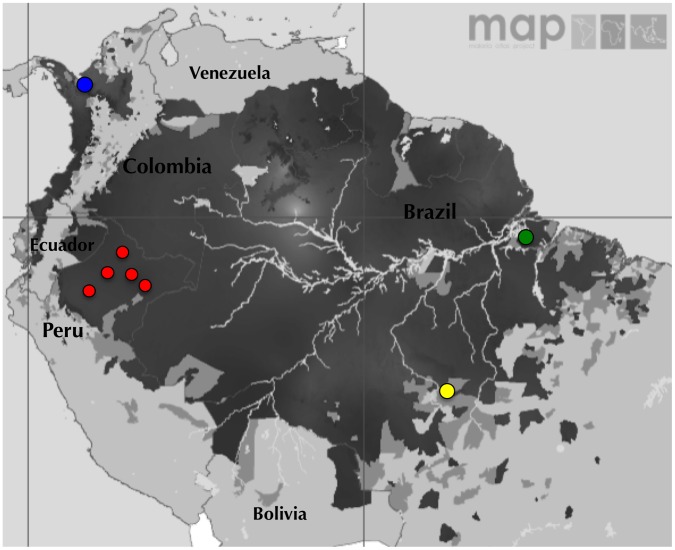

Plasmodium falciparum malaria endemicity in South America and geographic location of the sampling areas.The P. falciparum malaria endemicity for 2010 in South America is stratified according to API into stable transmission (dark grey areas; PfAPI ≥0.1 per 1000 per annum), unstable transmission (medium grey areas; PfAPI<0.1 per 1,000 per annum) and no risk or malaria free (light grey and white areas; PfAPI = 0) [81]. Circles represent populations sampled for this study: Urabá, Colombia (blue circles); Loreto, Peru (red circles); Belém and Mato Grosso, Brazil (green and yellow circles, respectively).